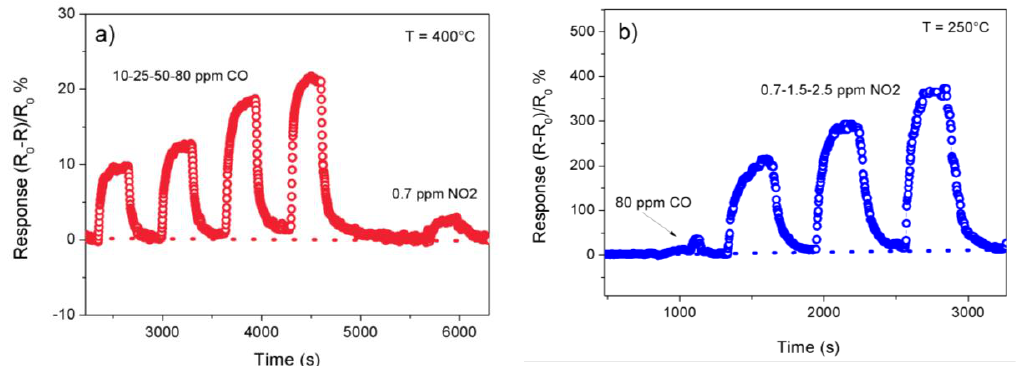
Figure 5. Dynamics of the response of the sensor to ( a ) CO and ( b ) NO 2 , at two different temperatures, under a dry air (RH < 3%) flow.